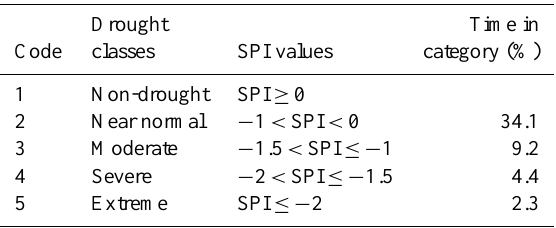
Table 1. SPI drought class classification (McKee et al.,